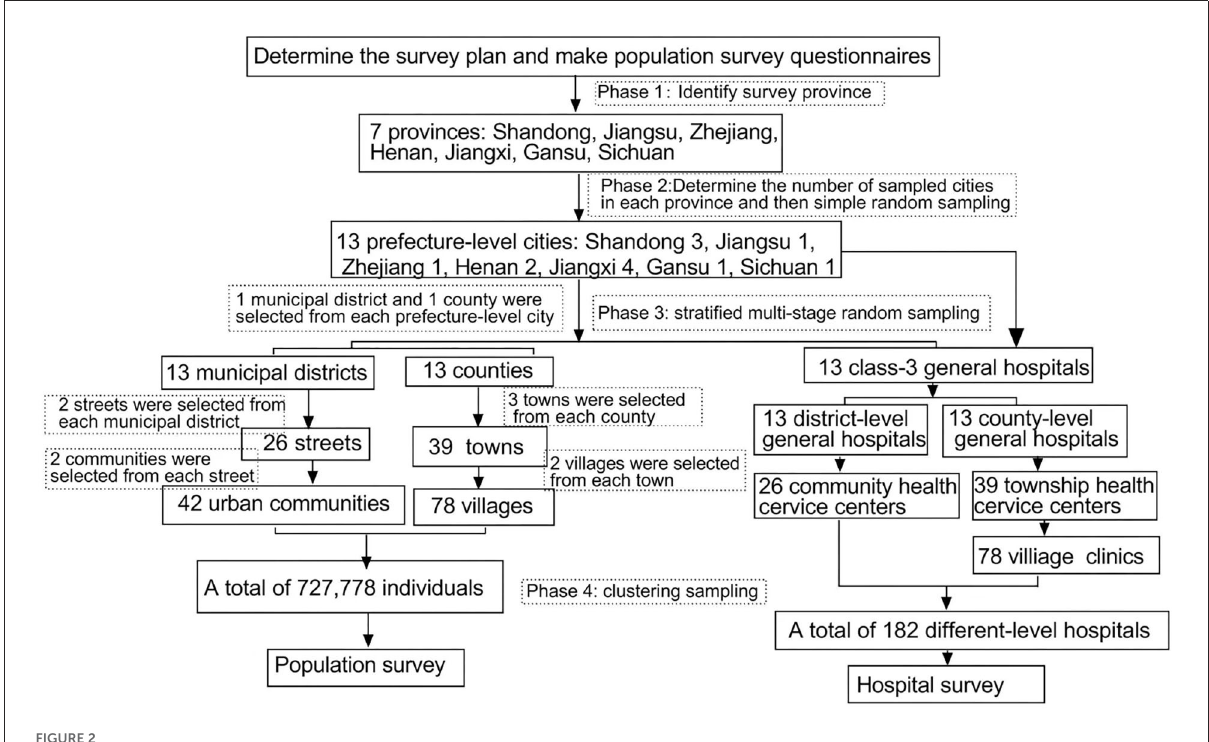
FIGURE2 Flow chart of epidemiological